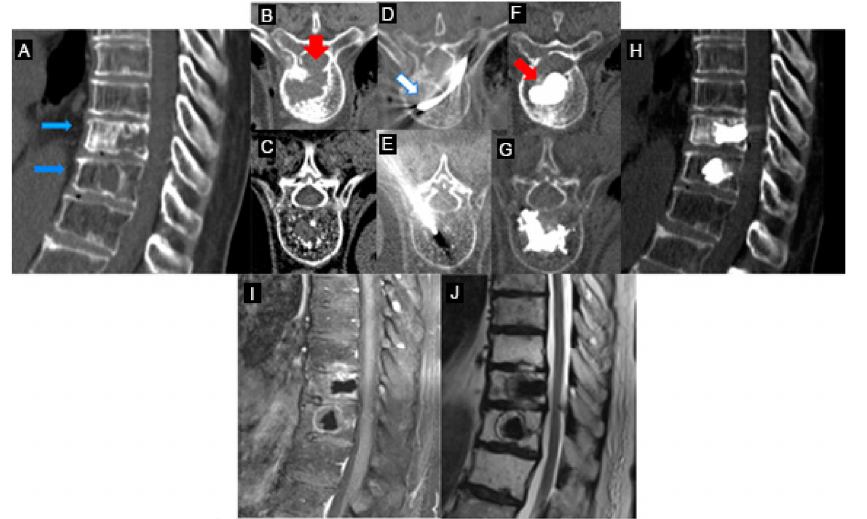
Figure 4. Painful pathological fractures of T8-T9 from lung carcinoma (patient #5-Table 1). ( A – C ): Axial and sagittal CT images of aggressive destructive osteoblastic metastasis of the T8 – T9 vertebral